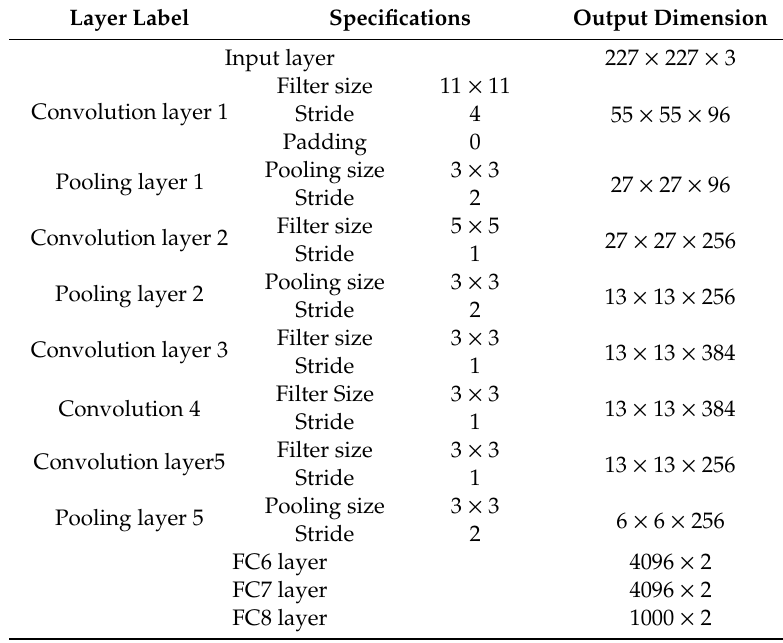
Table 1. The dimensions of di ff erent layers of the AlexNet deep convolution neural network